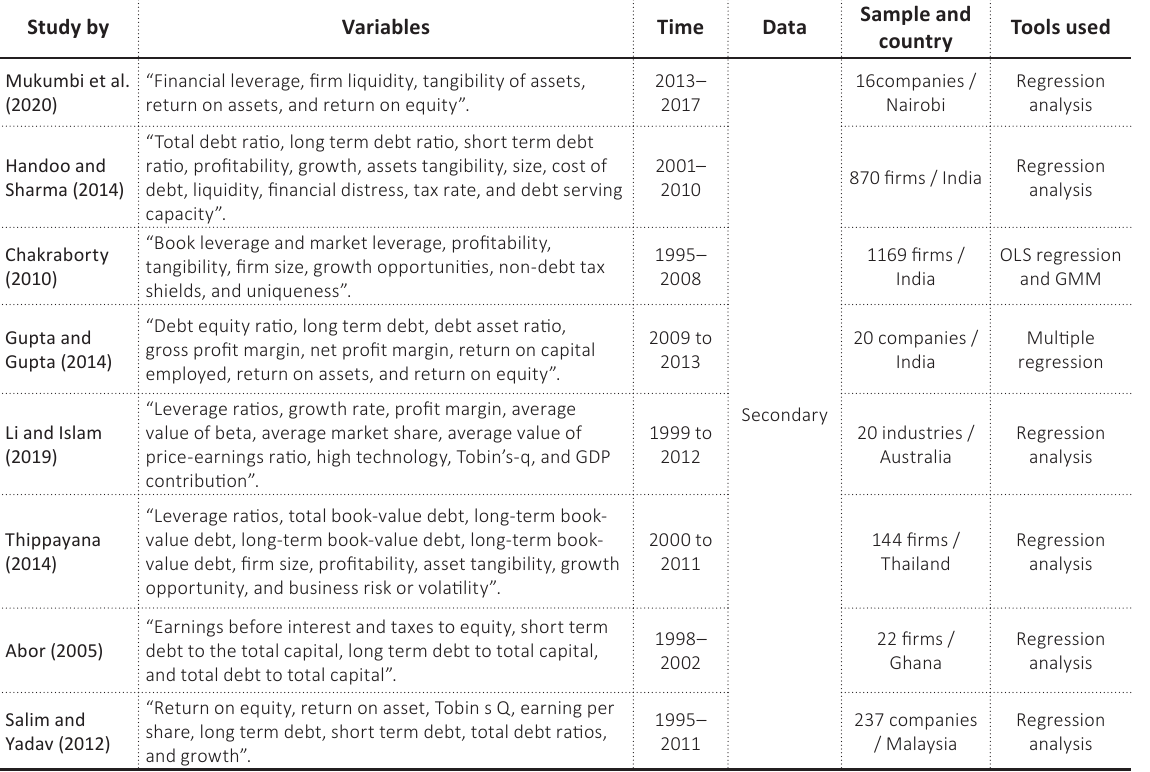
Table 1. Empirical studies of capital structure in different countries Study by